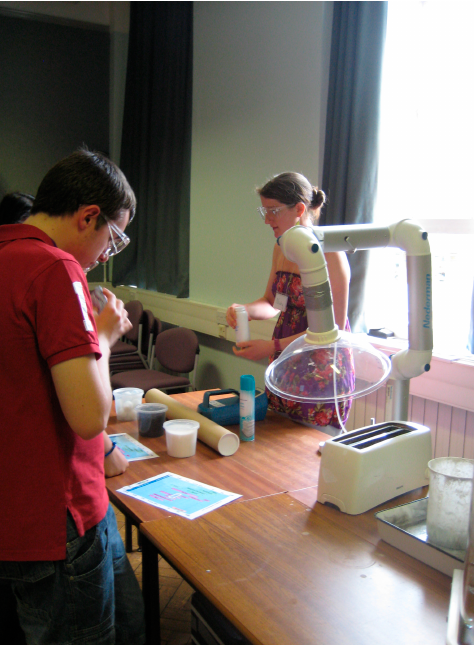
Figure 1. Students learn about aerosols in the